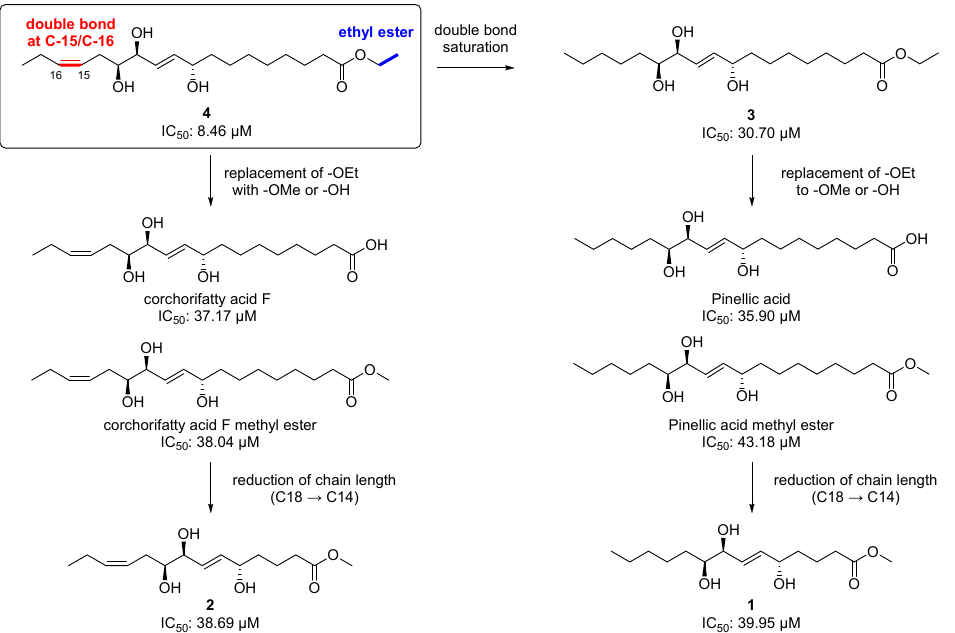
Figure 6. Structure–activity relationship (SARs) for the isolated metabolites ( 1–4 ) and other four structurally similar metabolites our group reported previously [8]. In addition to the anti-neuroinflammatory effect, several omega-3 oxylipins have also shown neuroprotective effect by decreasing inflammation and apoptosis [27–29], inhibit- ing astrogliosis [30], activating mitochondria [29], promoting angiogenesis, and regulat-